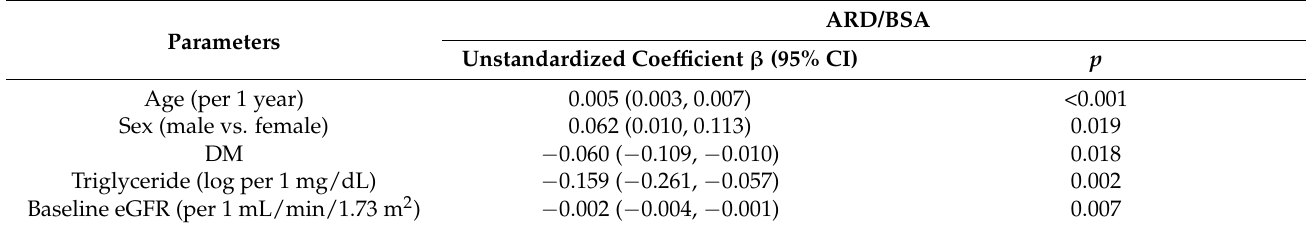
Table 3. Determinants of ARD/BSA using multivariable stepwise linear analysis.